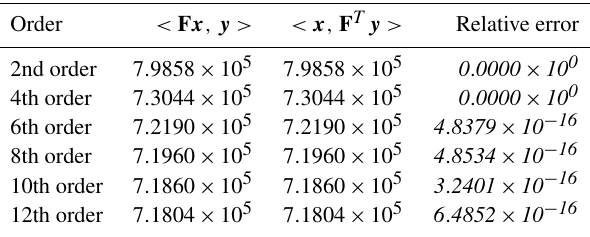
Table 1. Adjoint test for different discretization orders in 2-D, com- puted on a two-layer model in double precision. The highlighted values represent the error in the values and indicate at which deci- mal the error appears.